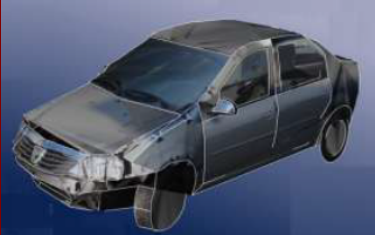
Figure 1. 3D Model created in PhotoModeler Scanner software with textures (Oniga et al.,